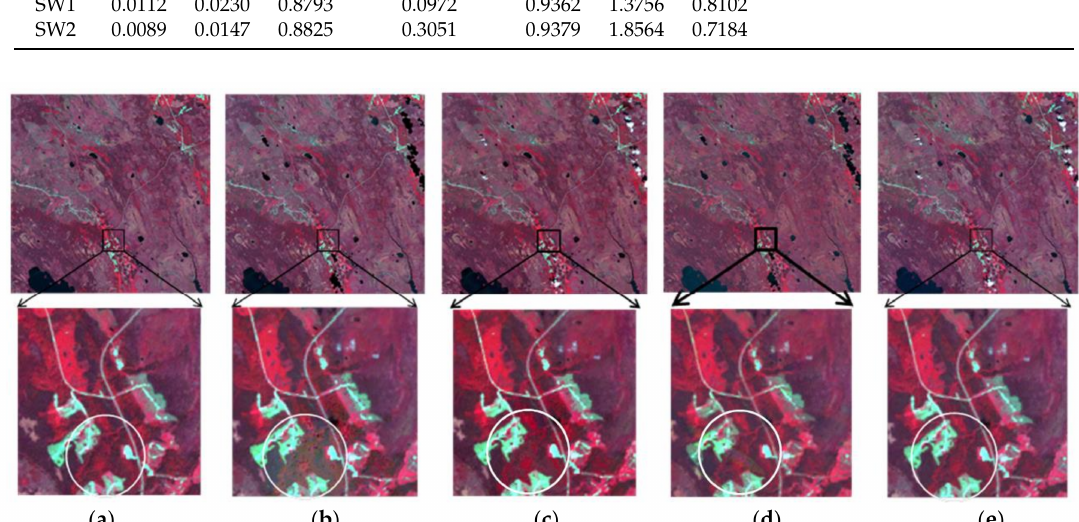
Figure 6. Comparison of forward prediction results of using Landsat image 192 to predict Landsat image 224. ( a ) Actual image; ( b ) STARFM; ( c ) FSDAF; ( d ); STI-FM; and, ( e )